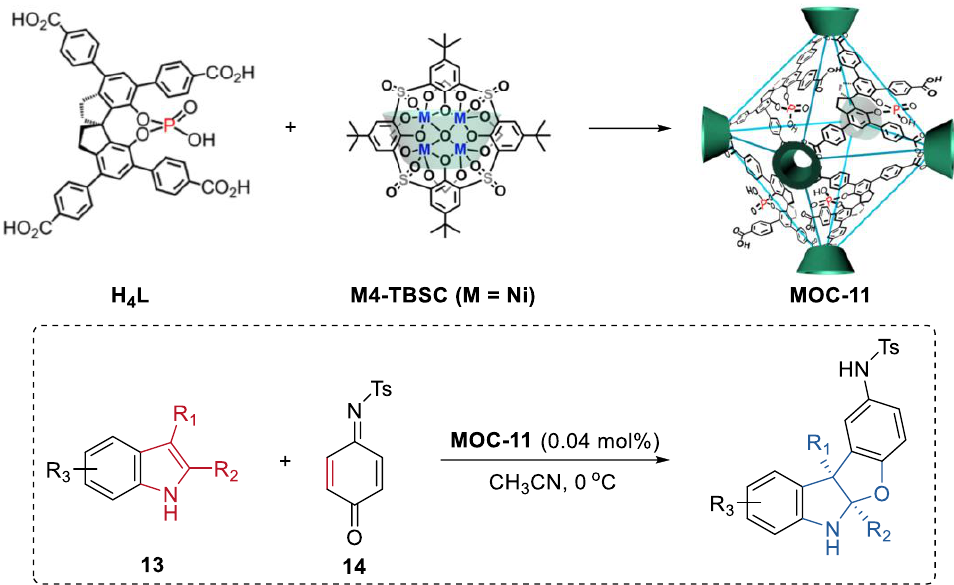
Figure 10. Asymmetric [3 + 2] coupling of indoles with quinone monoimine catalyzed by MOC-11 [70]. Reaction additions: 13 (0.10 mmol), MOC-11 (0.04 mol%), 14 (0.15 mmol), CH 3 CN, 0 °C. Reprinted/adapted with permission from Ref. [70]. Copyright 2020 Springer Nature Ltd.